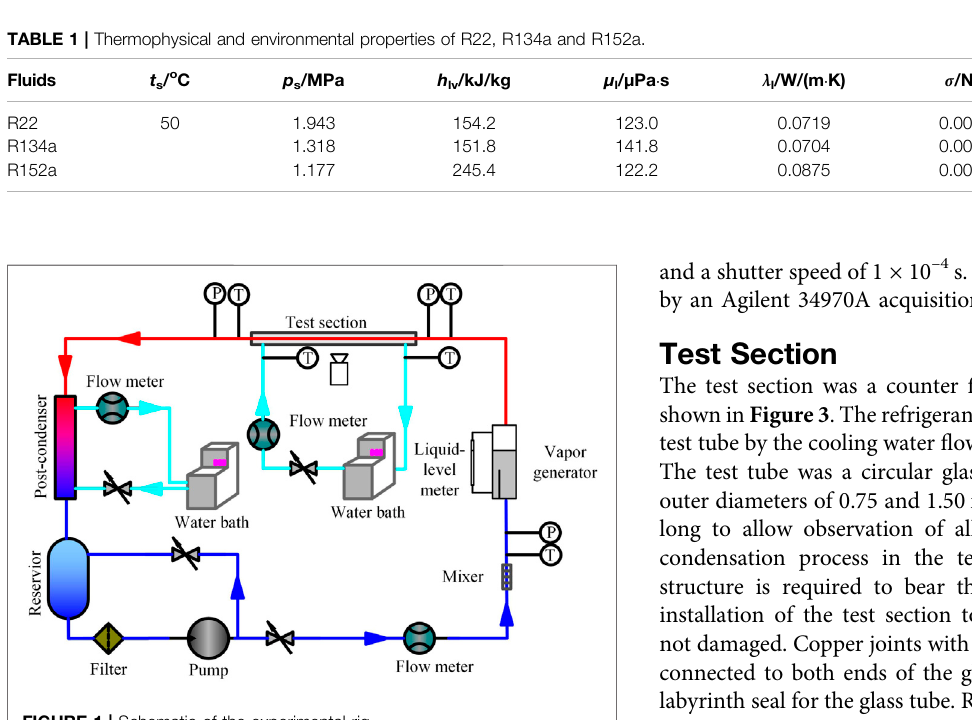
FIGURE 1 | Schematic of the experimental rig.